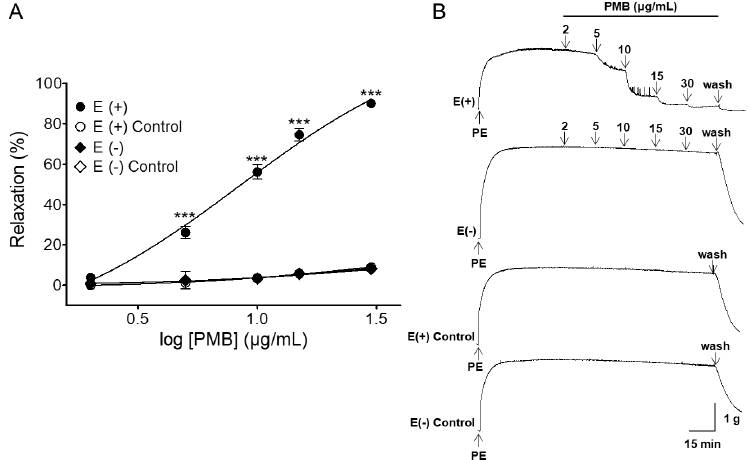
Figure 1. Cumulative concentration-response curves of PMB (2–30 μg/mL) in rat aortic rings with intact [(E+)] or denuded [(E−)] endothelium pre-contracted with phenylephrine (PE, 1 μM) ( A ).